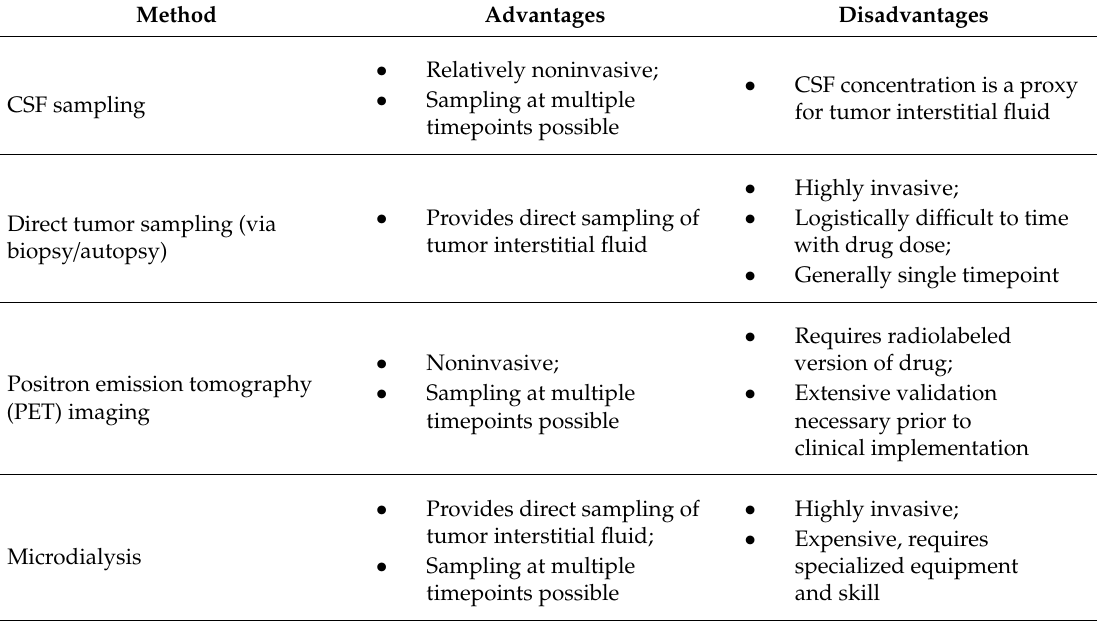
Table1. Methodstoassessdrugconcentrationattumorsite,